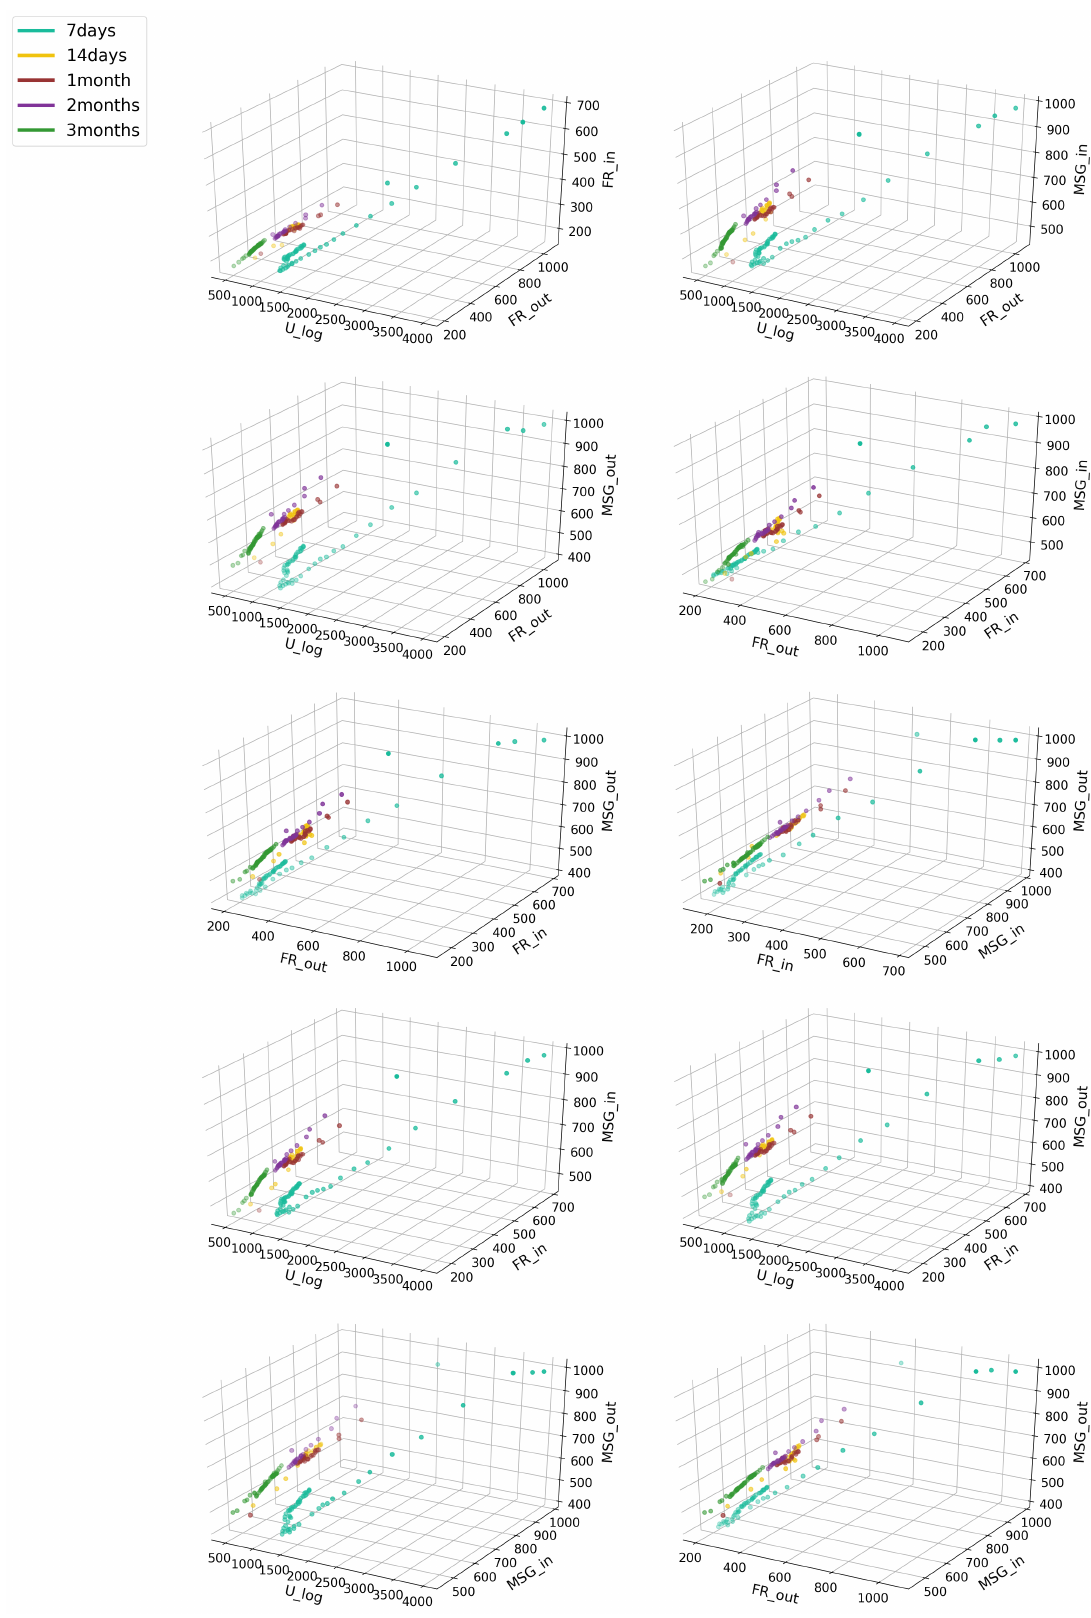
Figure A2. Dependence of objects in classes from all Experience